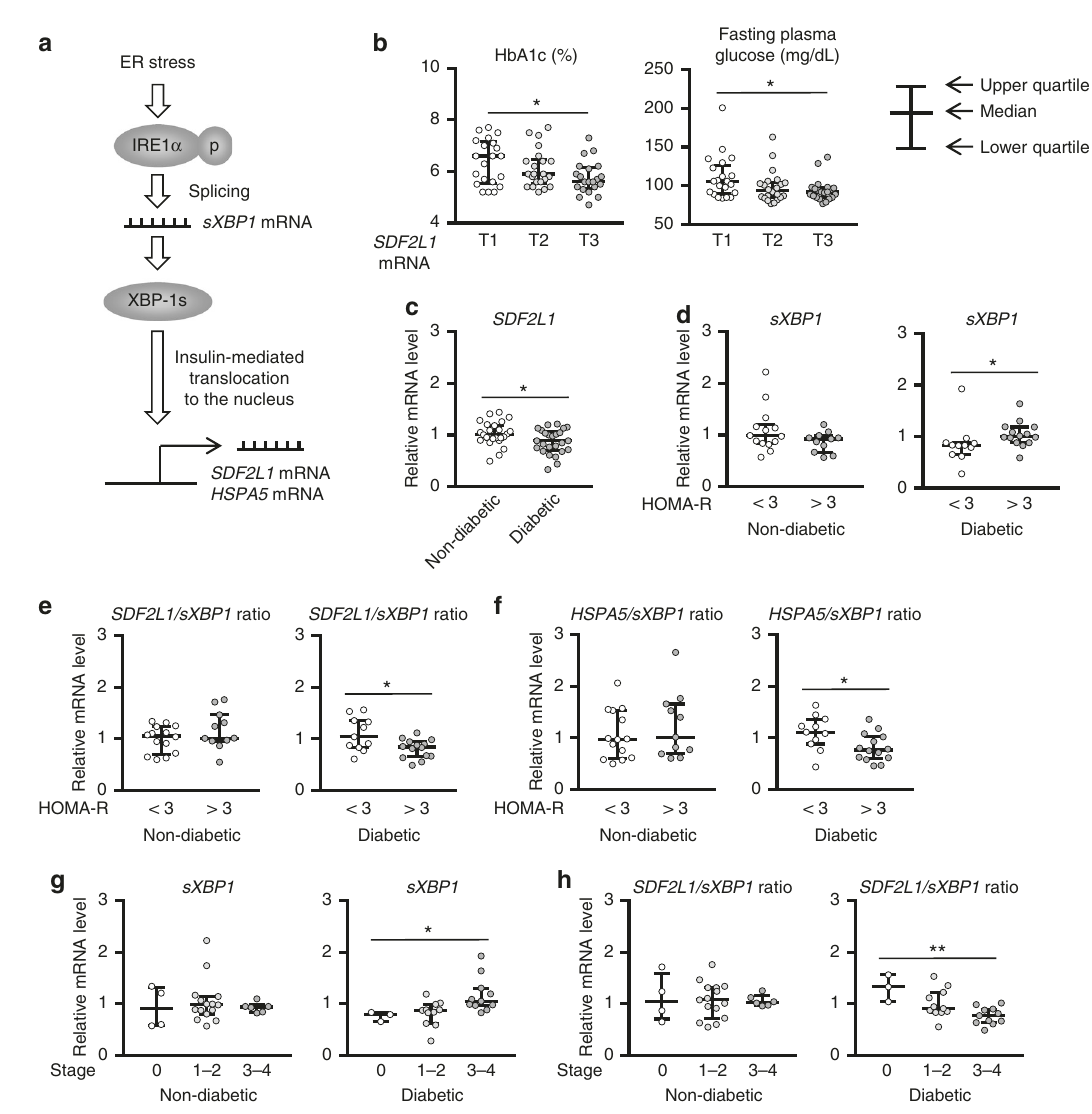
Fig. 7 ER stress responses in human subjects. Expression of ER stress marker genes and the ratios between them, in liver biopsy samples of human male subjects with suspected nonalcoholic fatty liver disease (NAFLD), analyzed by RT-PCR. a Schematic description of factors affecting expression of marker genes and ratios. b Correlation with glucose tolerance ( n = 64). c Comparison between diabetic ( n = 25) and matched nondiabetic subjects ( n = 25). d – h Correlation with progression of comorbid diseases in diabetic ( n = 25) and matched nondiabetic subjects ( n = 25), including d – f insulin resistance, and g , h staging of NASH. Data are shown in scatter dot plot with the median and interquartile range. * P < 0.05, ** P < 0.01, T tertile. b , g , h Spearman ’ s rank correlation was used, and c , e , f the Mann – Whitney U test was used for